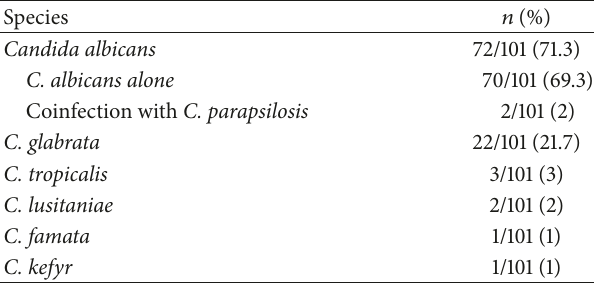
Table 2: Species identified in the literature review excluding 22 unidentified cases ( 𝑛 = 101